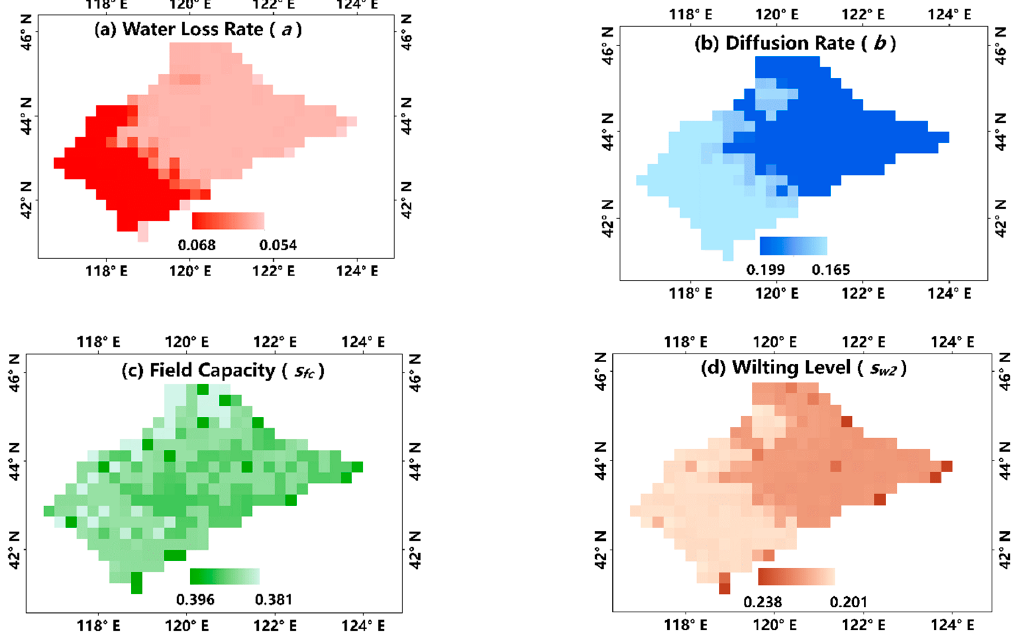
Figure 5. Regional maps of the SMAR parameters predicted by the RF model, including ( a ) water loss rate a , ( b ) diffusion rate b , ( c ) relative field capacity s c1 and ( d ) relative wilting level s w2 .